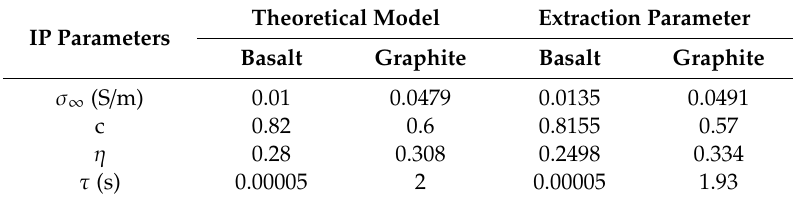
Figure 18. 3D polarization model. Table 3. Extraction results of the polarization parameters of the 3D polarization model with noise.